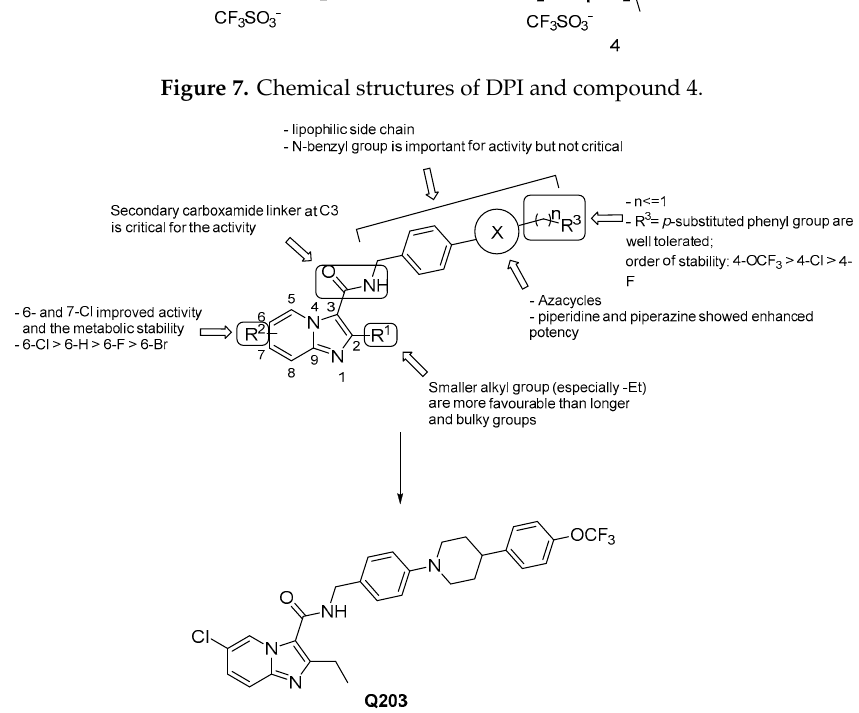
Figure 8. SARs of imidazo [1,2- a ] pyridine-3-carboxamides and chemical structure of Q203.